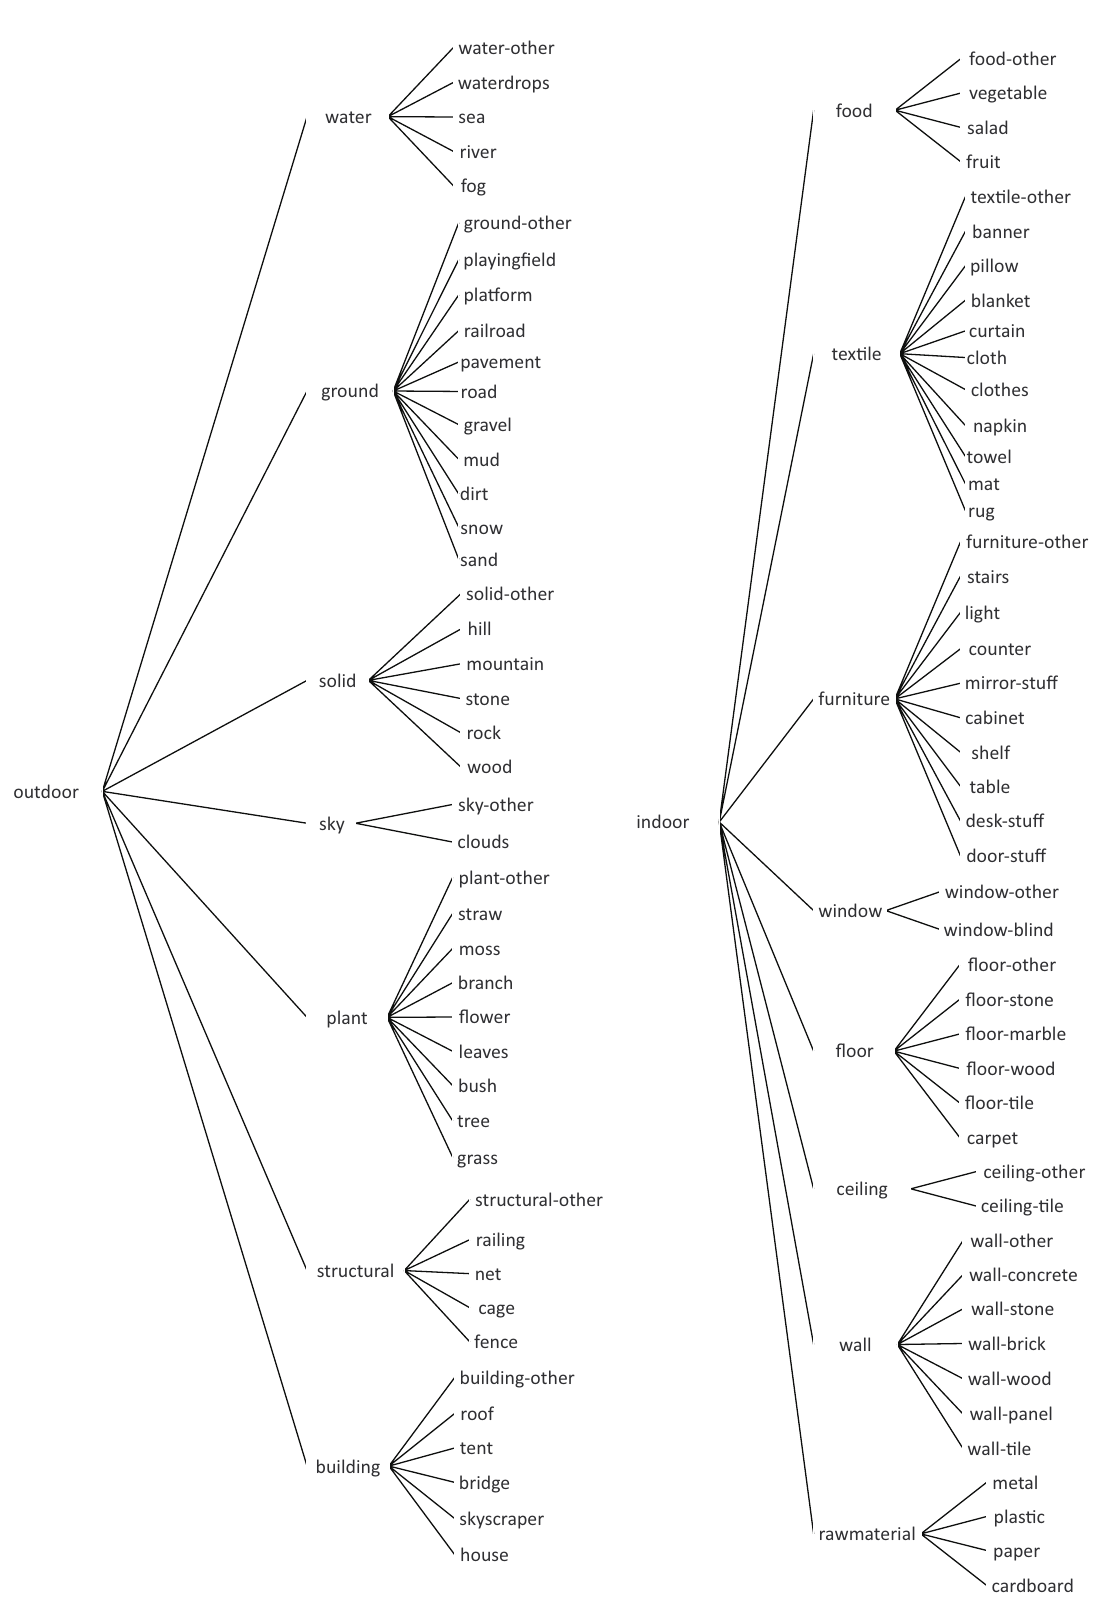
Figure 2. COCO-Stuff label